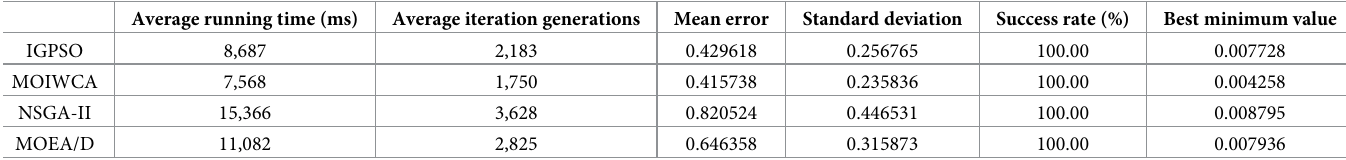
Table 1. Comparison of test results of Rosenbrock function using MOIWCA, IGPSO, NSGA-II and MOEA/D. Average running time